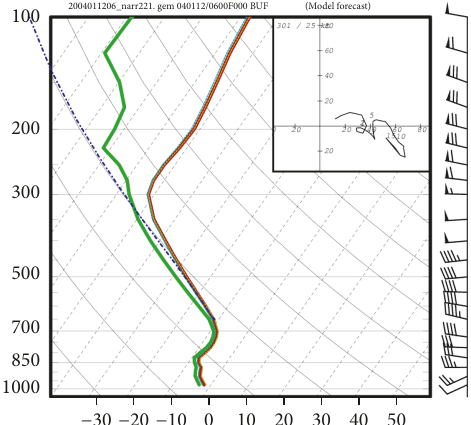
(a) Skew- 𝑇 log 𝑝 thermodynamic diagram of temperature (solid red, ∘ C) and dew point (solid green, ∘ C) for Buffalo, New York, at 0600 UTC 12 January 2004 from the NARR. Wind barbs follow as in Figure 9